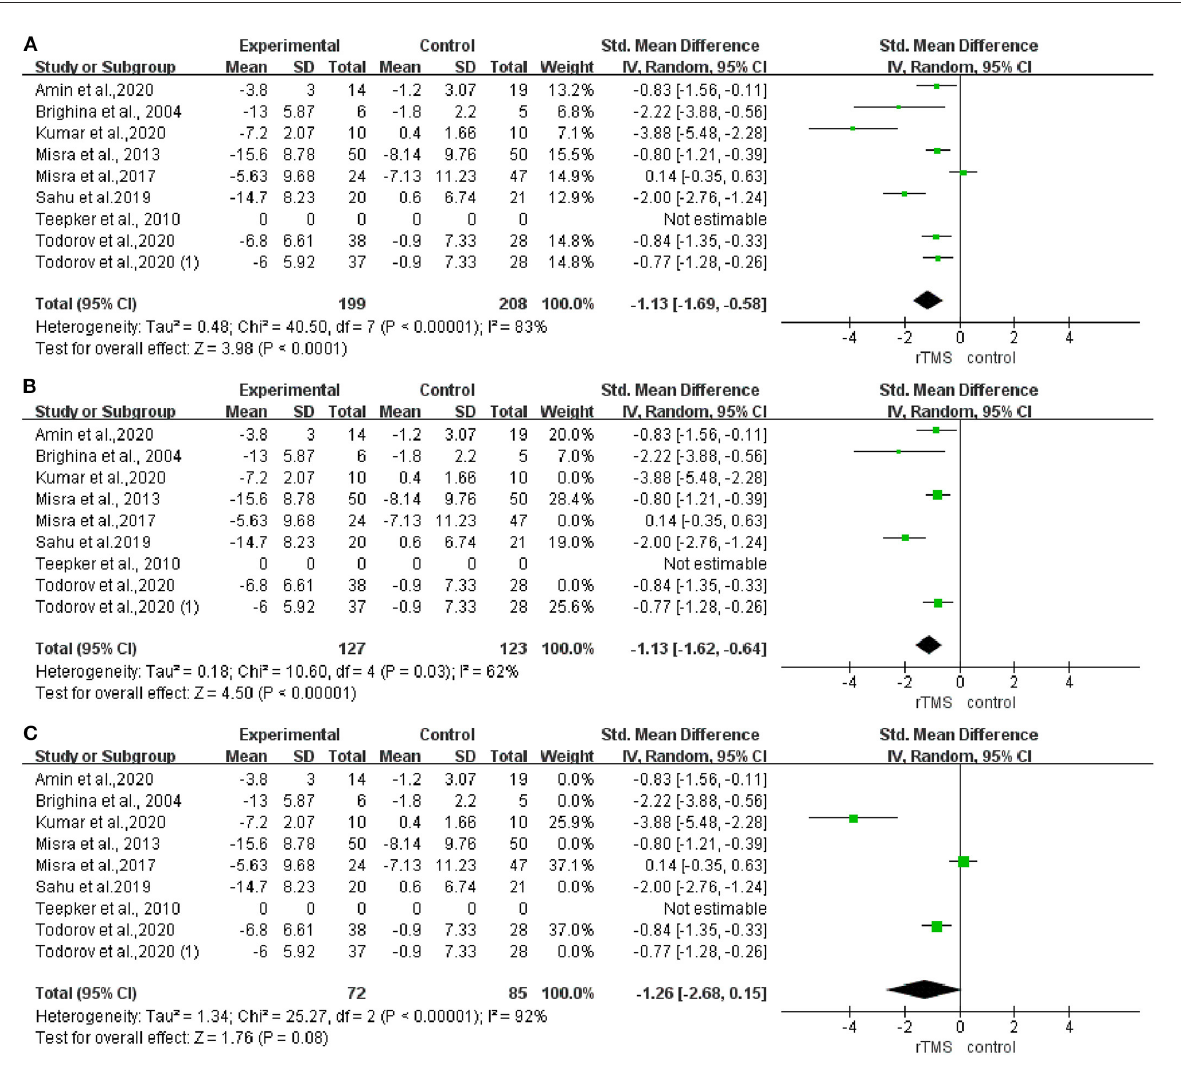
FIGURE4 Forest plot of the frequency of headache attacks. (A) LDLPFC/motor cortex stimulation. (B) LDLPFC stimulation. (C) Motor cortex